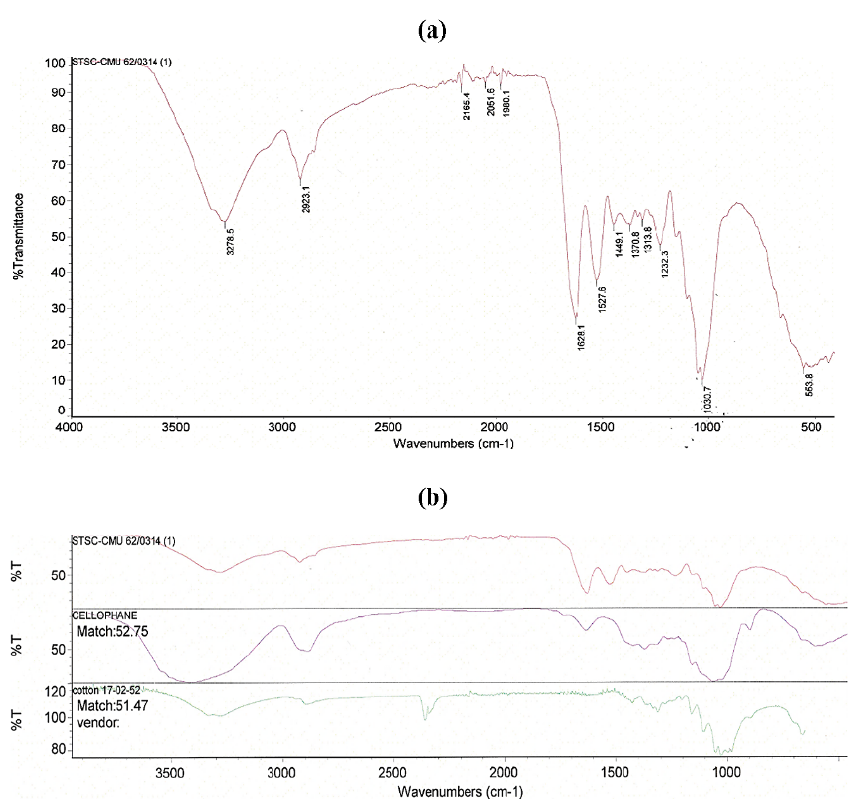
Figure 8. FTIR spectrum of bacterial cellulose obtained from K. maltaceti P285 cultivation in HS medium at 30 °C for 21 days ( a ); when compared with database ( b ).